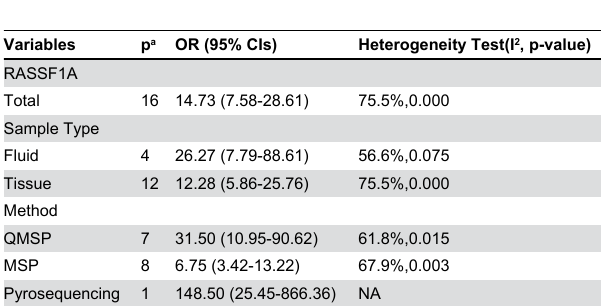
Table 2. Stratification analyses of RASSF1A methylation and prostate cancer